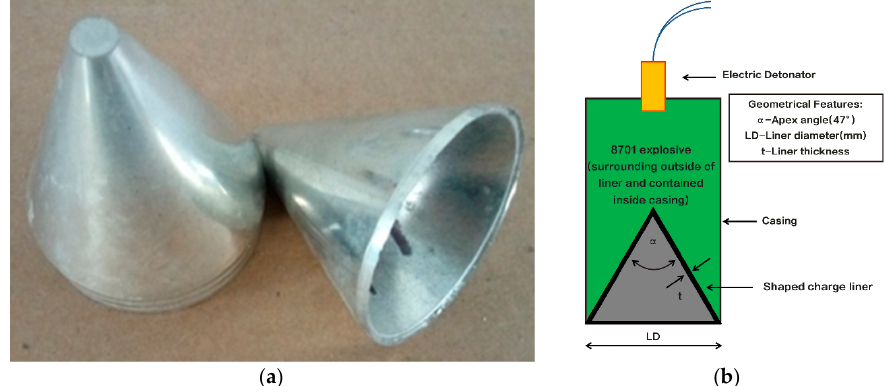
Figure 2. ( a ) Reactive-shaped charge liners and ( b ) the schematic of a shaped charge device.